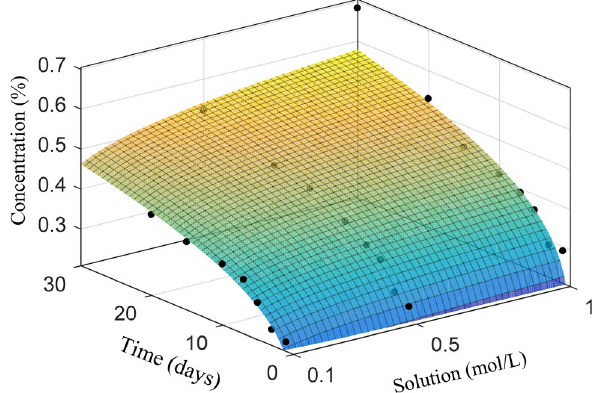
Fig. 6 Time-dependent surface concentration and fitting results